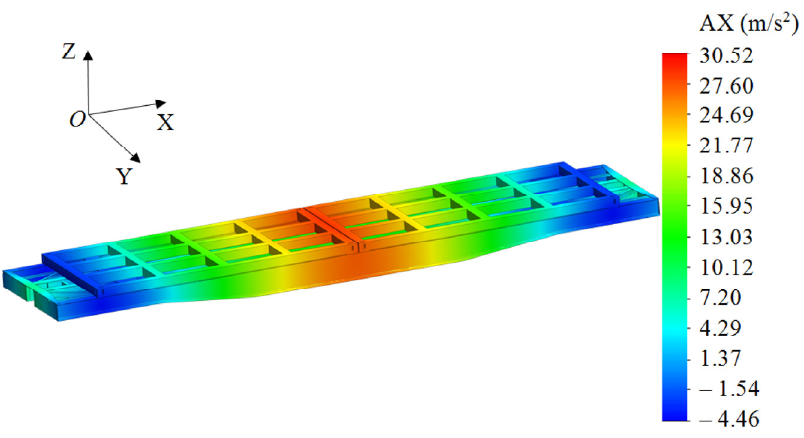
Figure 11. Design diagram of the bearing structure of a flat wagon loaded with removable modules (AX is the acceleration that acts about the longitudinal axis X).